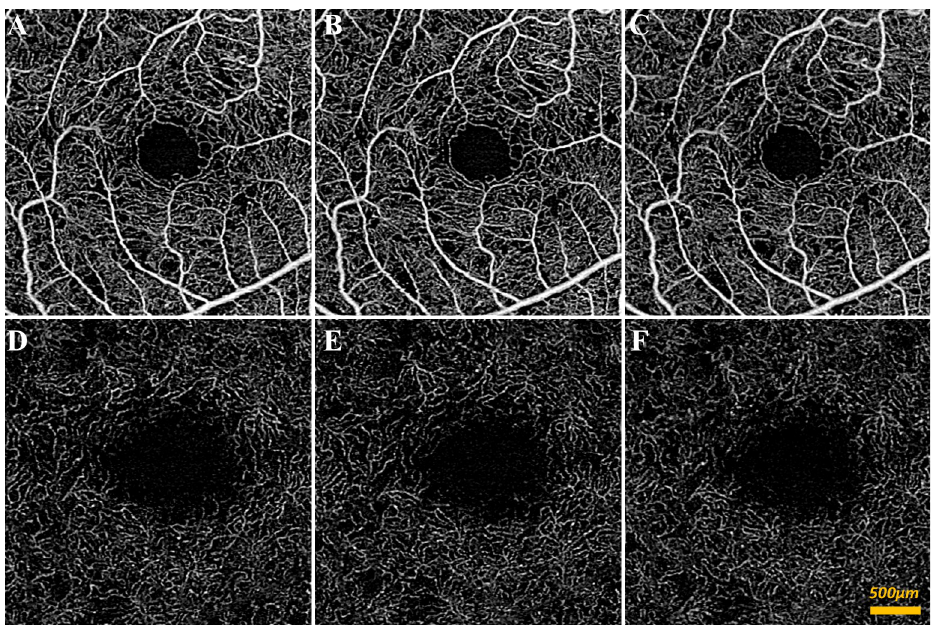
Fig 3. SS-OCTA of diabetic subject without diabetic retinopathy during different gas conditions. (A-C) 3x3mm en face superficial retinal layer image of blood flow around central macula during oxygen condition (A), room air condition (B), and carbon dioxide condition (C). (D-E) 3x3mm en face deep retinal layer image of blood flow around central macula during oxygen condition (D), room air condition (E), and carbon dioxide condition (F).